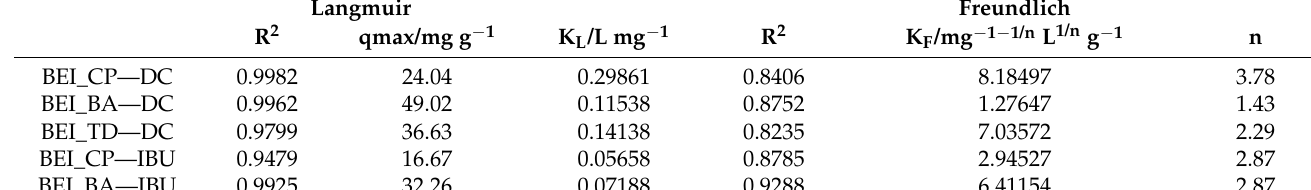
Table 2. Isotherm parameters of IBU and DC onto modified beidellites.